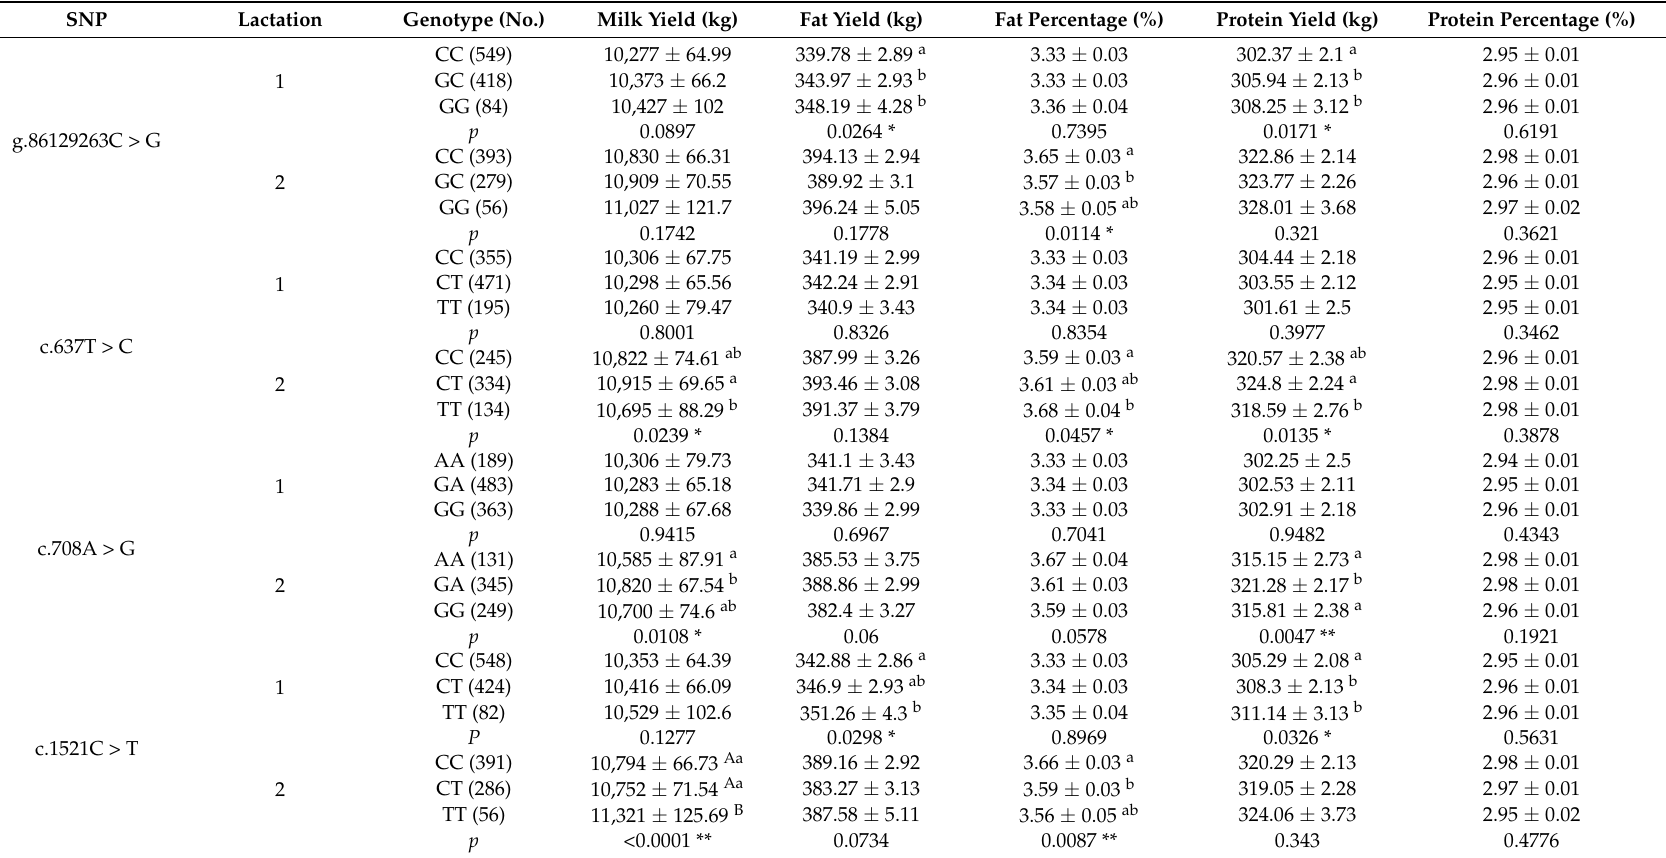
Table 2. Associations of seven SNPs with milk production traits in two lactations in Chinese Holstein (LSM ±